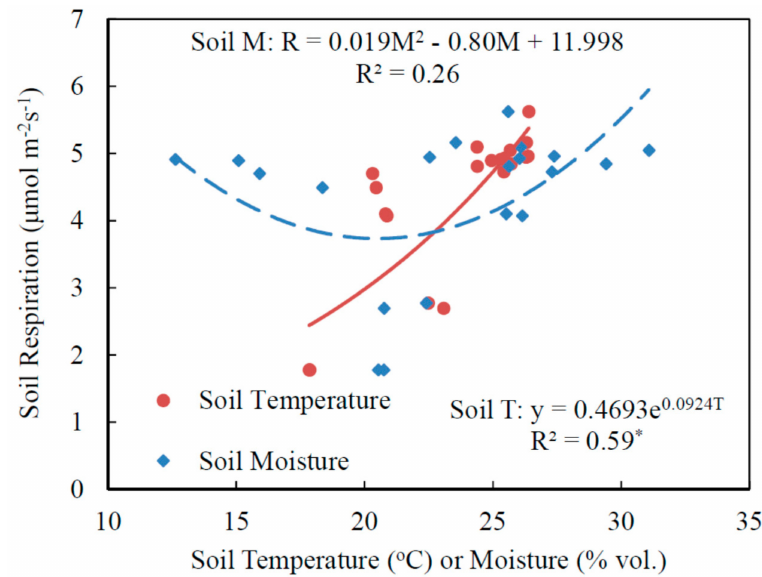
Figure 4. Relationships between soil respiration ( µ mol CO 2 m − 2 s − 1 ) and soil temperature (T, ◦ C), and soil moisture (M, % vol.). Data points are means of treatments. Each data point is calculated from 32 pot measurements in two blocks. * indicates significant at α = 0.05